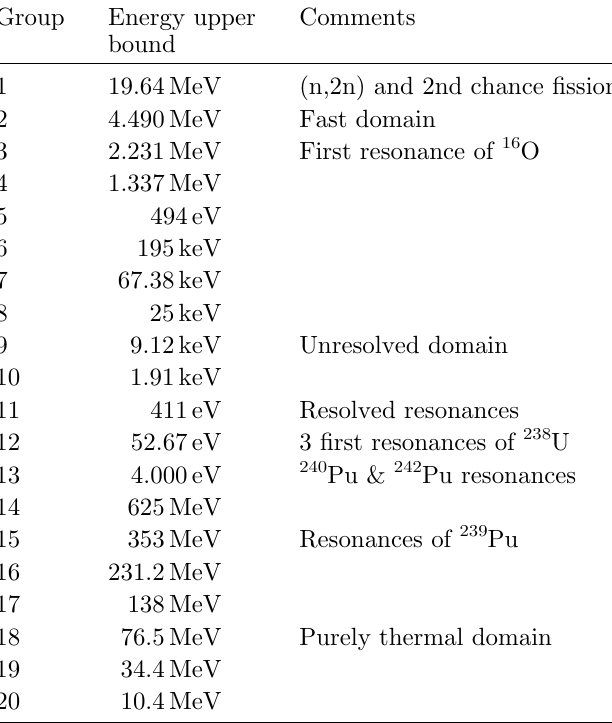
Table 1. Description of the 20 groups energy mesh.